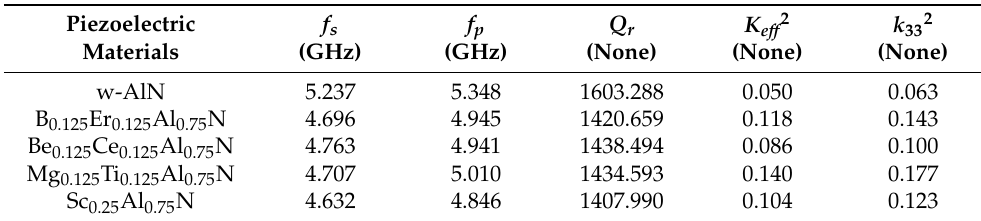
Table 2. Resonant characteristics of the resonator based on doped/undoped w-AlN. f s and f p represent resonant frequency and anti-resonant frequency. K eff 2 and Q r are calculated by COMSOL software. k 332 is calculated according to Equation